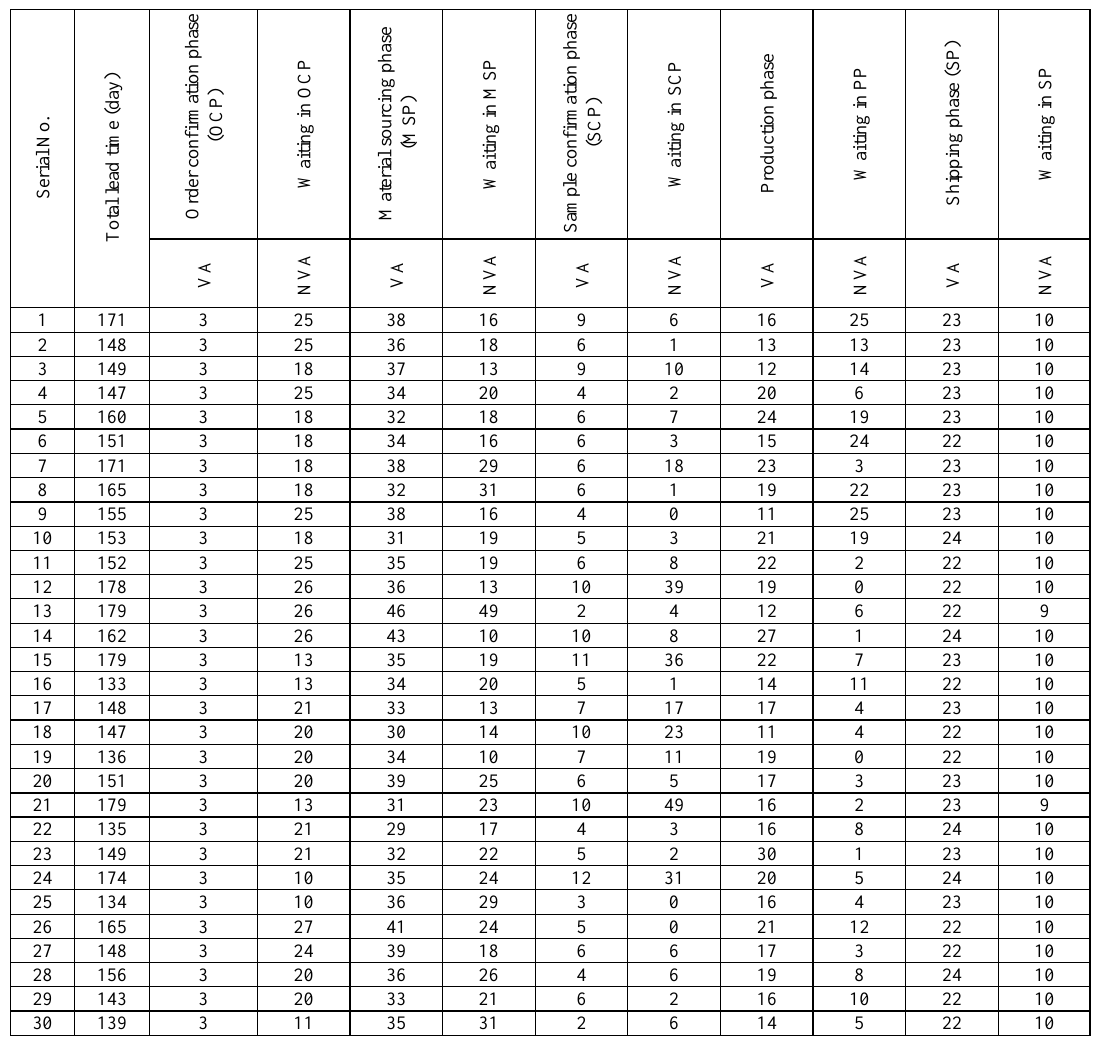
Table 3. Phase wise value-added and non-value-added activity in days